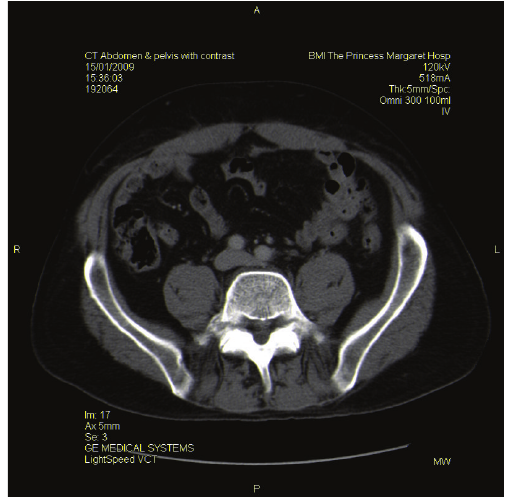
Figure 5: Anterior fusion of L5/S1 with intervertebral cage and bone